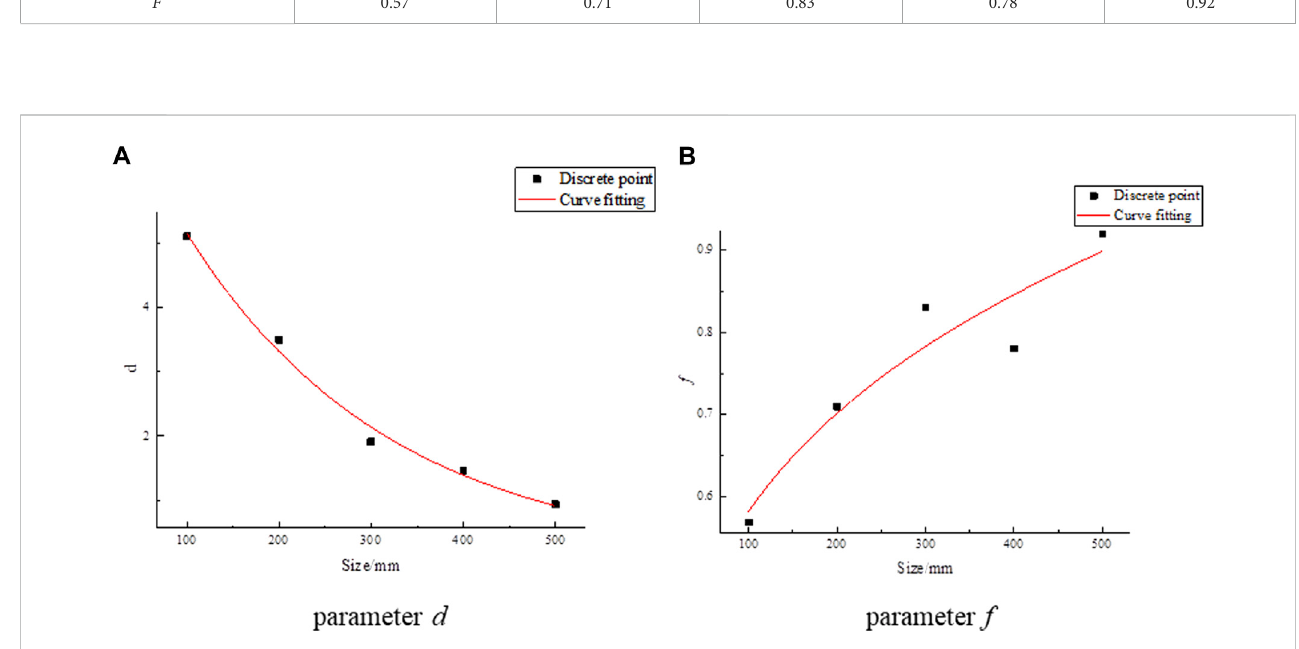
FIGURE 7 Fitting curve of parameters and rock